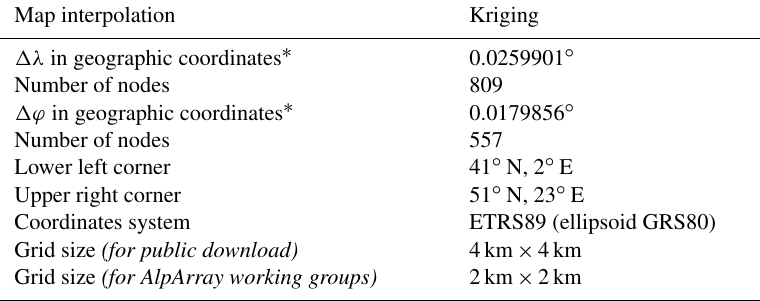
Table 3. Summary of map-relevant information.